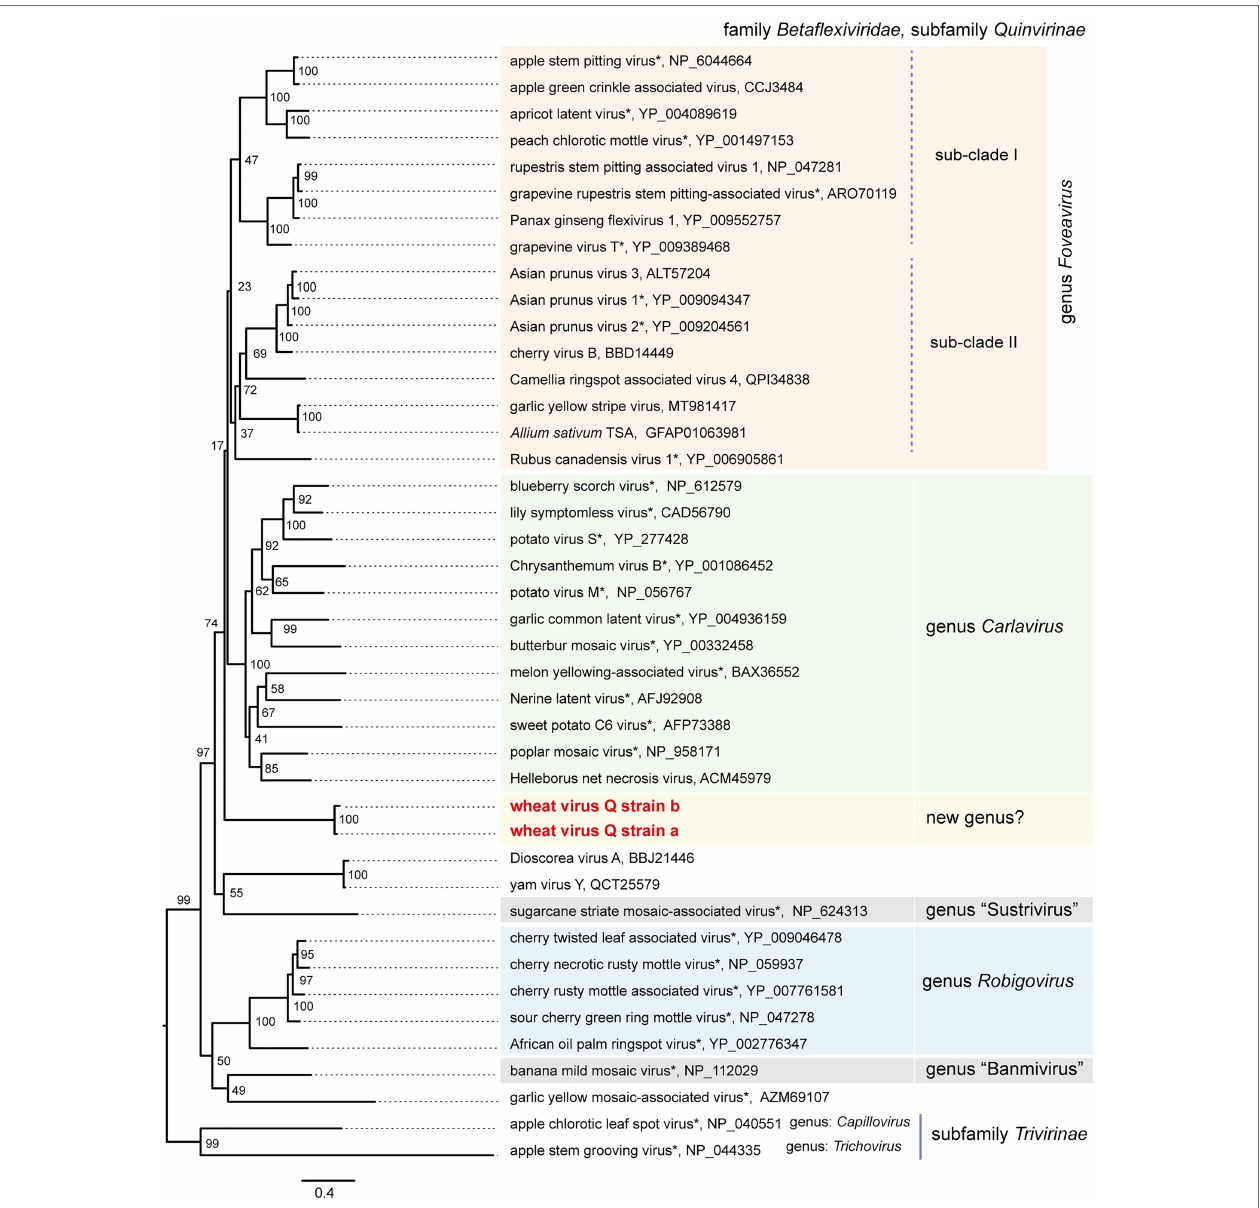
FIGURE 4 | Phylogenetic relationships of the quinviruses and other unassigned related viruses. A maximum likelihood phylogenetic tree was constructed using a MAFFT alignment of the full-length replicase amino acid sequences. Ambiguously aligned sequences were removed using Gblocks with the stringency levels lowered for all parameters. A model LG + I + G + F was selected as a best-fit model for the alignment (the 1,235 positions remaining in the input dataset). The tree with the highest log likelihood ( − 43,188,80) is shown. The tree was drawn using the midpoint rooting method. The virus names referring to plant viruses [genera Foveavirus , Carlavirus (selected), Robigovirus , and floating (proposed genera “Banmivirus” and “Sustrivirus”) or unassigned members of subfamily Quinvirinae , family Betaflexiviridae ] are followed by the GenBank accession or Ref-seq numbers of their sequences. Virus names with asterisks show representative members of the viral species. The two betaflexiviruses – apple chlorotic leaf spot virus (genus Trichovirus ) and apple stem grooving virus (genus Chapillovirus ) – of subfamily Trivirinae (family Betaflexiviridae ) were used as the outgroups. The scale bar represents amino acid distances. The numbers at the nodes in the tree are bootstrap support values following 100